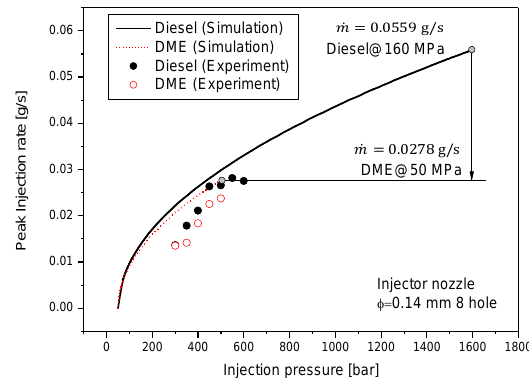
Figure 6. Peak injection rate according to injection pressure.